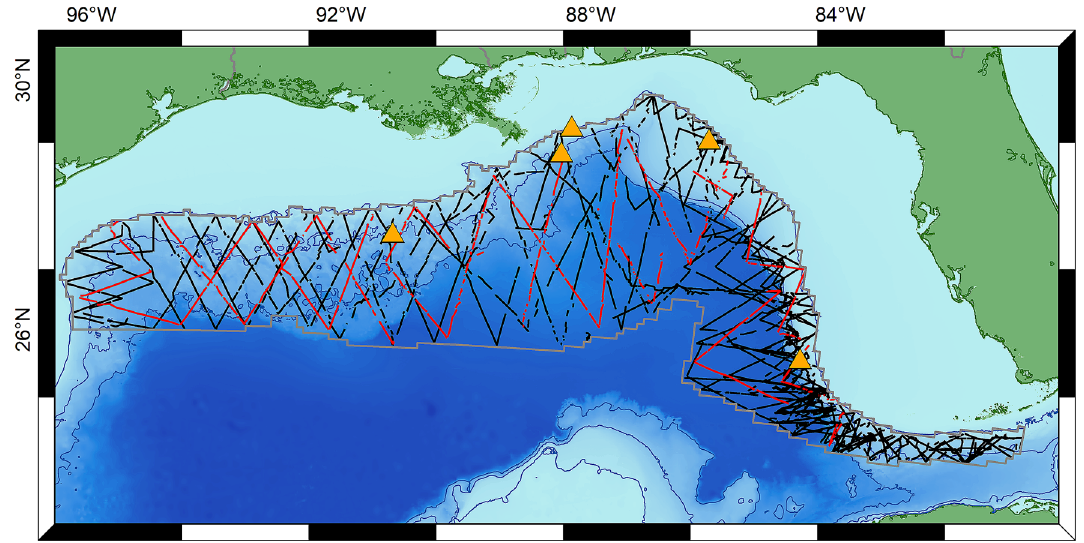
Figure 1. Map of GOM visual survey effort for five NOAA cruises between 2003 and 2014 (lines) and passive acoustic monitoring locations (orange triangles). The 2009 cruise effort (red lines) was used for model testing. Track lines for all other years, used for model training, are shown in black. The gray outline shows the extent of the modeled region, a pelagic area encompassing depths greater than 200 m within the US EEZ. Bathymetric contours (blue lines) are shown for the 200 m, 1000 m and 2000 m contours (Map created using ArcGIS software by ESRI 29